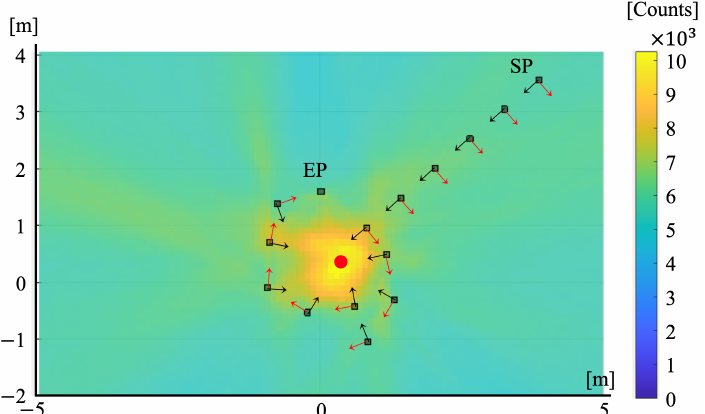
Figure 20. Experimental results: the blue and red arrows represent the directions of the first and second principal components, respectively. The ground truth of the location of the radiation source is represented by a red dot. It can be confirmed that the radiation source distribution was successfully estimated around the ground